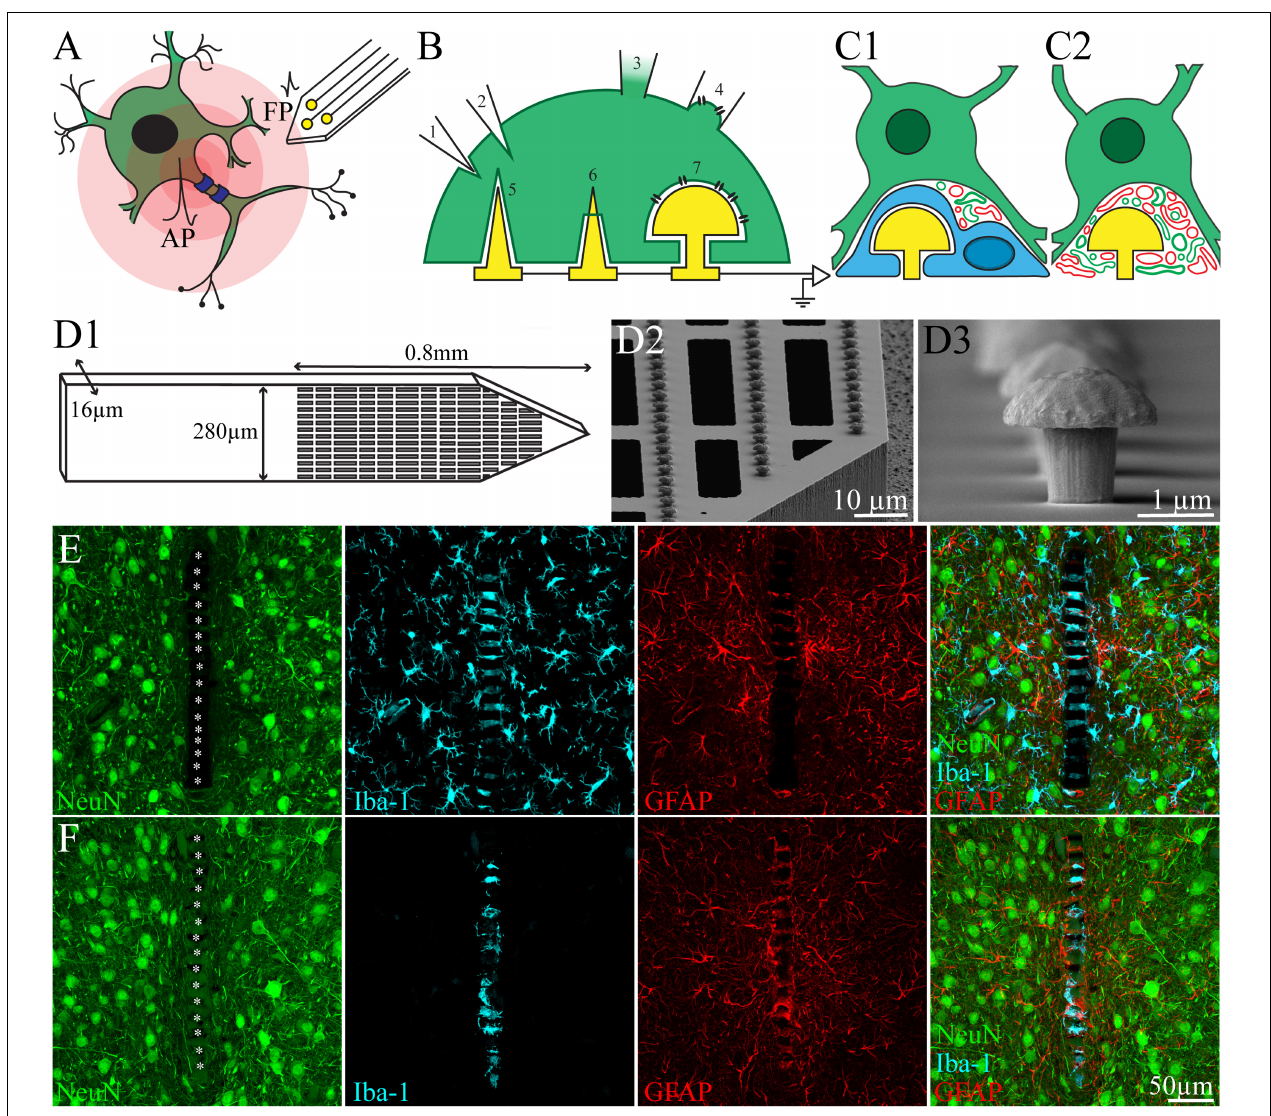
FIGURE 1 | (A) Schematic drawing of extracellular field potentials (FPs) recording by implanted neuroprobe. FPs (in the form of first time derivative of an action potential- AP) generated by a neuron (green) are attenuated across the extracellular spaces (centripetal pink shells). Extracellular positioned neuroimplants (yellow) sense and record the FPs but are “blind” to the rich background of subthreshold synaptic potentials that communicate between neurons and play major roles in neuroplasticity. (B) Schematic drawing of neuro-technologies that enable to record the entire brains electrophysiological signaling repertoire. (B1,B2) Depicting a sharp glass-microelectrode that pierces the plasma membrane of a neuron to gain intracellular accesses. (B3) A cell attached patch electrode forming a G (cid:127) seal with the raptured plasma membrane to gain intracellular access. (B4) A perforated cell attached configuration in which the plasma membrane is sucked into the patch electrodes and the sucked membrane is nano-perforated to increase its conductance. (B5–B7) Schematic drawing of in-vitro vertical naopillars for parallel intracellular recording from cultured excitable cells. (B5,B6) A sharp vertical nanopillar engulfed (B5) and pierces the cell’s plasma membrane (B6) . (B7) An engulfed mushroom-shaped vertical microelectrode forms an analog configuration to that of the perforated patch electrode shown in (B4) . (C1,C2) schematic drawings of the biological structures that impede the application of the vertical nanopillar technologies to in-vivo brain conditions. (C1) A microglia (cyan) form a high impedance seal over the electrode, mechanically isolate and electrically insulate it from the neurons (green). (C2) Regenerating neurites (green) and branches of astrocytes (red) occupy the space between the neuron and the microelectrodes. The formed space shunts a large fraction of the current generated by the neuron. (D1) Schematics of the polyimide based perforated MEA platform (PPMP), the proximal solid part and distal perforated part are shown. (D2) SEM image showing the perforations of the polyimide platform and the dense rows of gM µ Es along the PI “ribs”. (D3) SEM image of a gM µ E. (E,F) Identification of a microglia that tightly adhere to the PI platform and insulate the electrodes even after the elimination of the microglia population from the parenchyma by the CSF1R inhibitor PLX5622. (E) Control, (F) PLX5622 treated rat. Shown are immunohistological sections of the implants along with the cortical parenchyma. Note the distribution of neurons (green), microglia (cyan), and astrocytes (red), around the PPMP implant. For purposes of orientation, the solid PI "ridges" in between the pores of the PPMP are labeled by white asterisks. (F) In PLX5622 fed rats the cortex is 95% depleted of microglia. However a PLX5622 resistant microglia population remains adhering to the PPMP and insulates the electrodes. Modified with permission from Sharon et al.